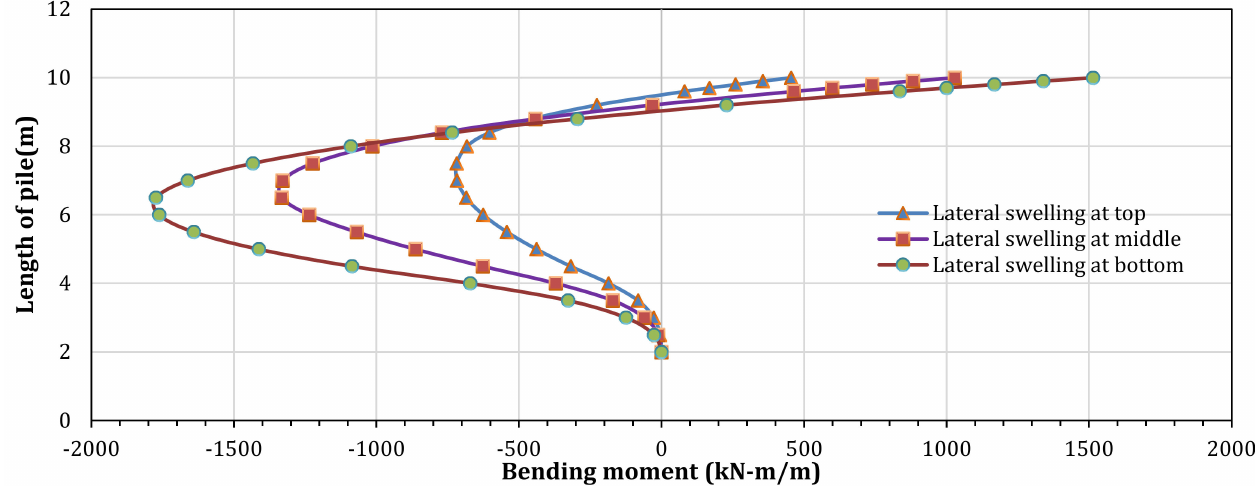
Figure 20. Bending moment on pile due to lateral swelling.